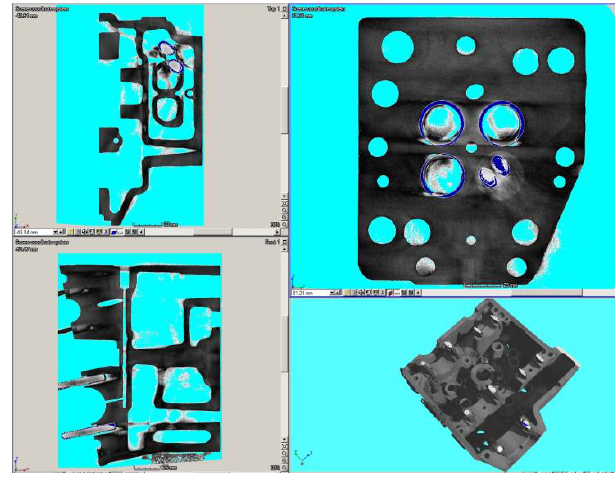
Fig. 11. View of the test engine headspace during tomographic examina- tion In order to reproduce structural elements, high accuracy of the internal structure of the object is required. To in-